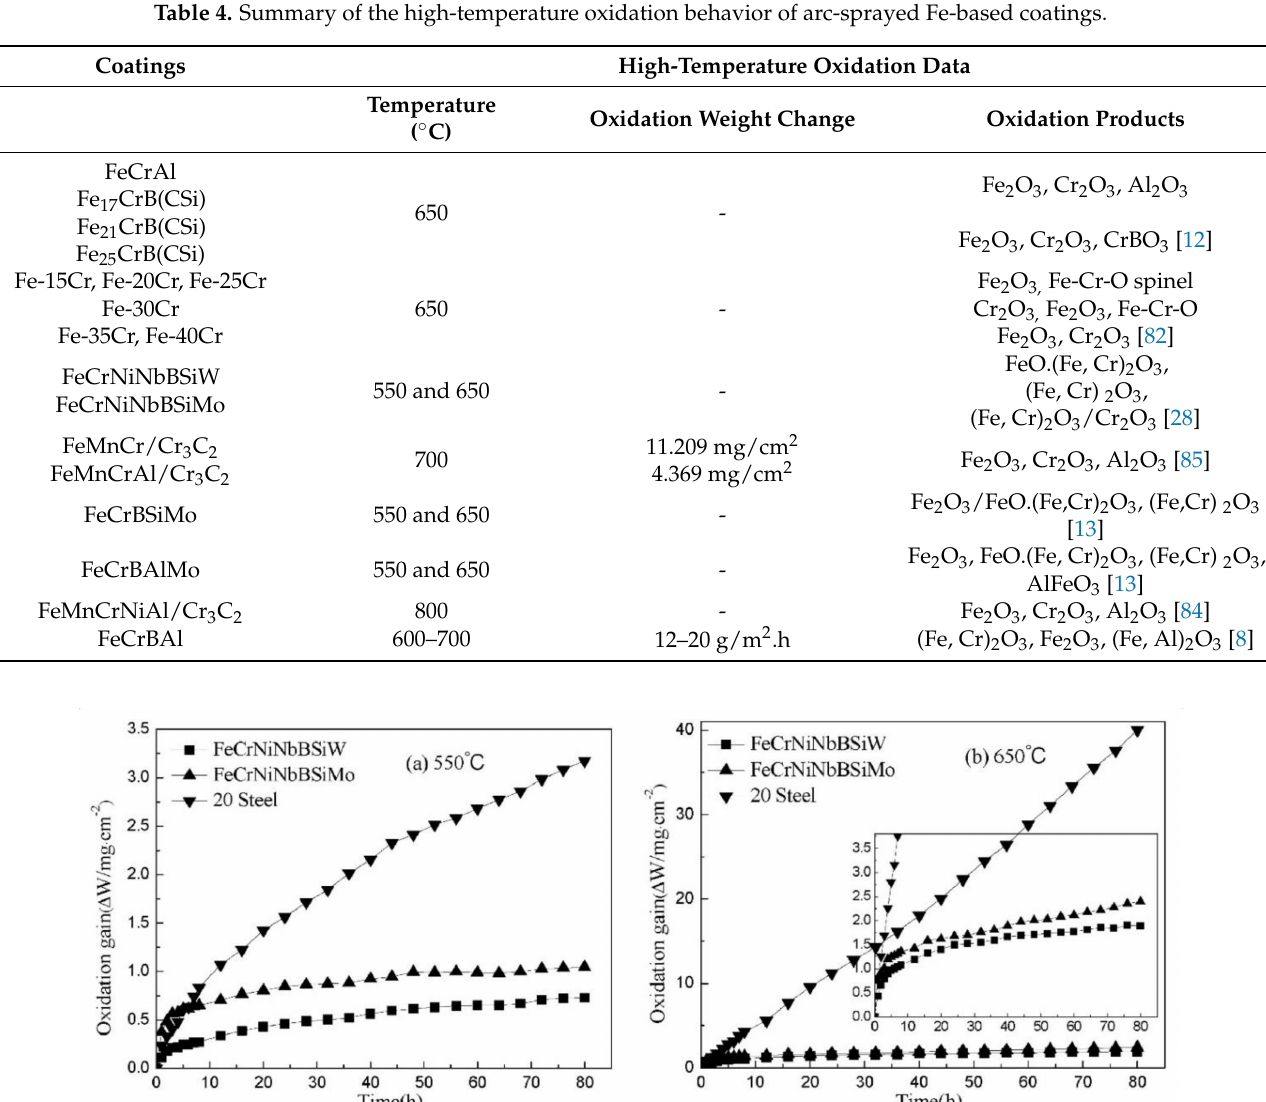
Table 4. Summary of the high-temperature oxidation behavior of arc-sprayed Fe-based coatings.